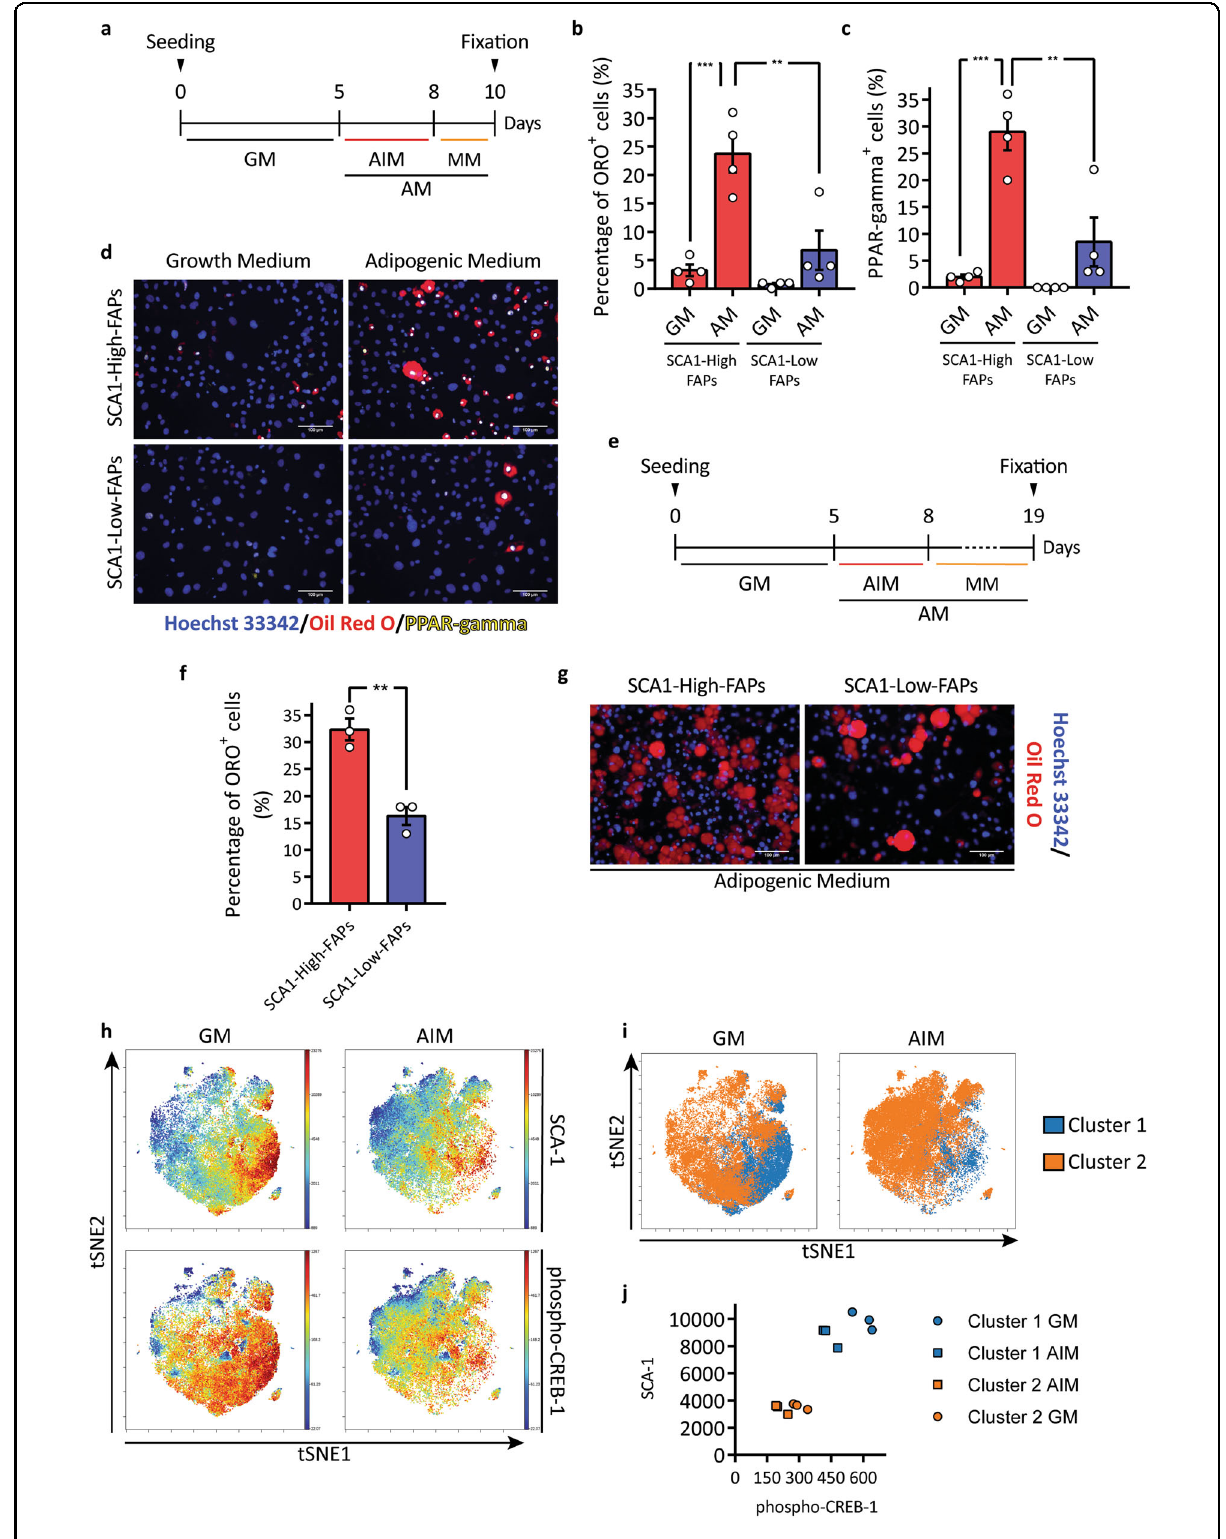
Fig. 3 (See legend on next